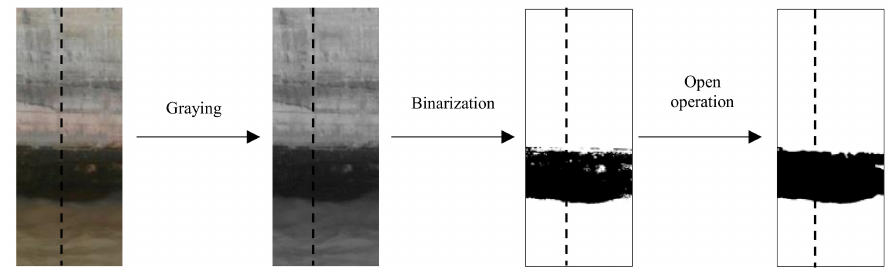
Figure 7. Effect of image